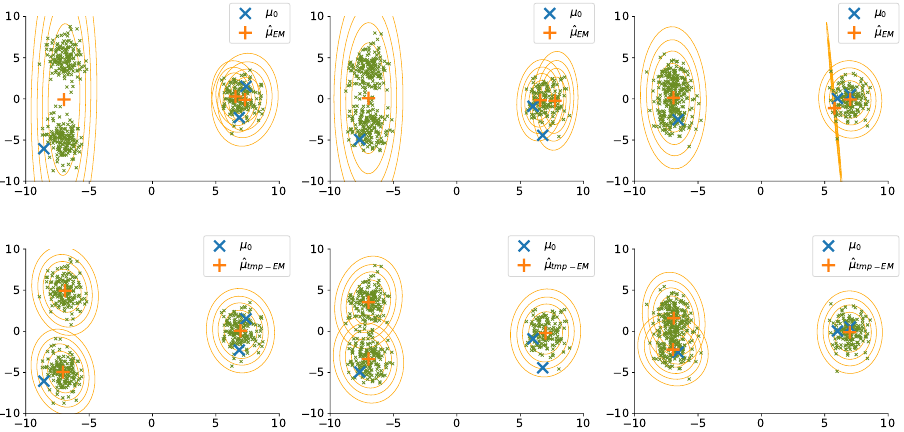
Figure 6. Typical final positioning of the centroids by EM (first row) and tmp-EM with oscillating profile (second row) when the initialisation is made by selecting two points in the isolated cluster and one in the lower ambiguous cluster (blue crosses). The three columns represent the three gradually more ambiguous parameter sets. Each figure represents the positions of the estimated centroids after convergence of the EM algorithms (orange cross), with their estimated covariance matrices (orange confidence ellipses). In each simulation, 500 sample points were drawn from the real GMM (small green crosses). In those examples, although EM kept two centroids on the isolated cluster, tmp-EM managed to correctly identify the position of the three real